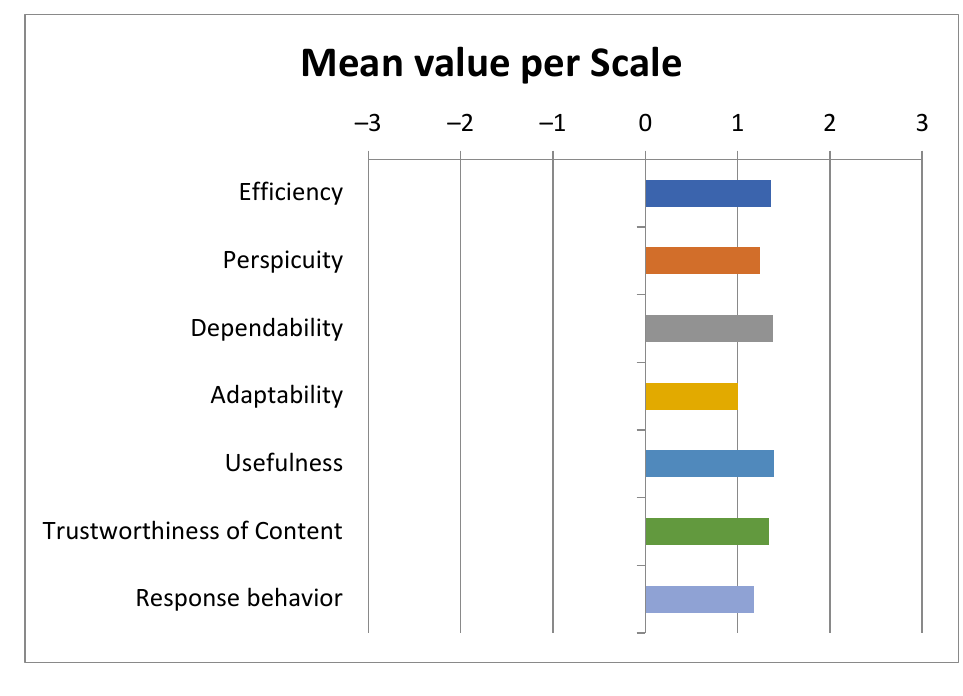
Figure 9. Mean value per Scale.